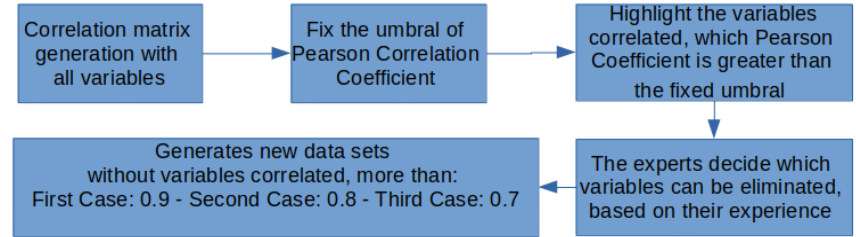
Figure 2. Block diagram of the steps to select the correlated variables. Correlation Matrix Generation with All